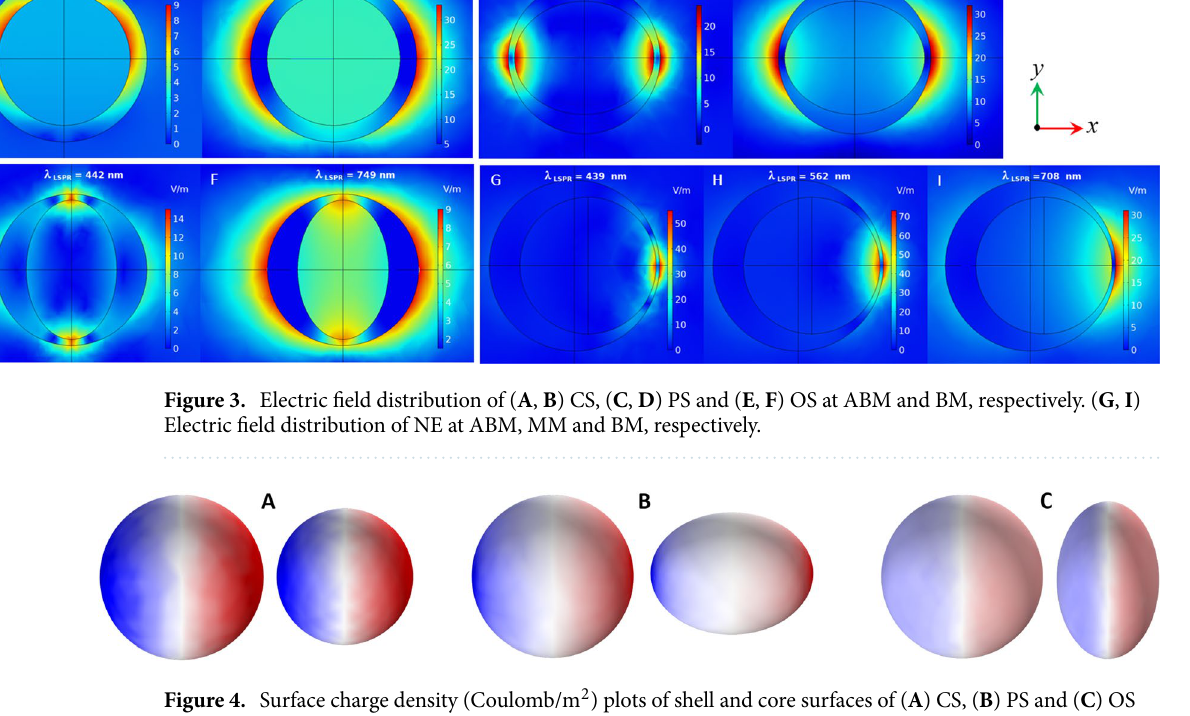
Figure 4. Surface charge density (Coulomb/m 2 ) plots of shell and core surfaces of ( A ) CS, ( B ) PS and ( C ) OS for bonding